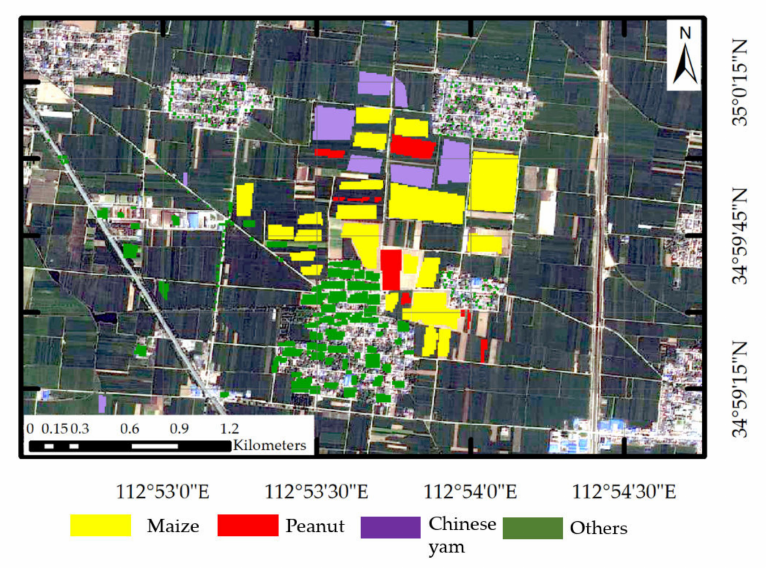
Figure 3. Examples of labels from field visits. Table 4 lists the ratio of labeled area to corresponding crop area. The crop area data came from the 2020 Jiaozuo City Statistical Yearbook data. Table 4. Ratio of labeled area to corresponding crop area.